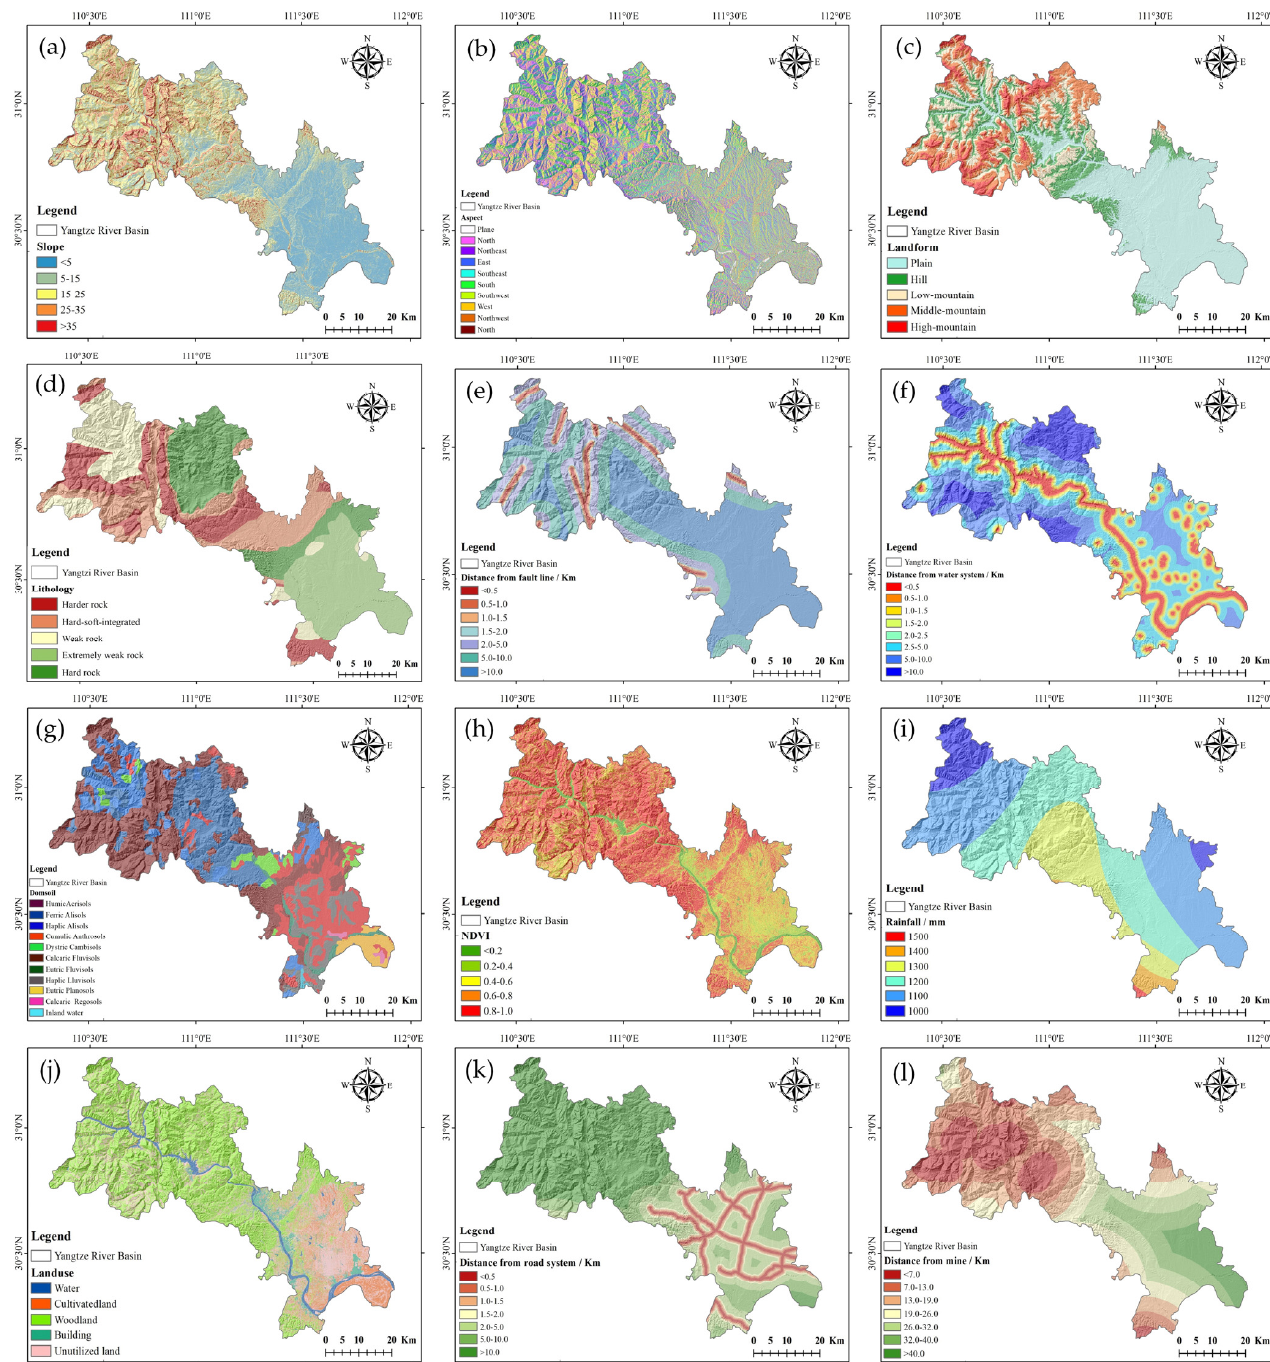
Figure 4. Thematic map of factors. ( a ) Slope; ( b ) Aspect; ( c ) Landform; ( d ) Lithology; ( e ) Distance from fault; ( f ) Distance from water; ( g ) Domsoil; ( h ) NDVI; ( i ) Rainfall; ( j ) Landuse; ( k ) Distance from road; ( l ) Distance from mine.